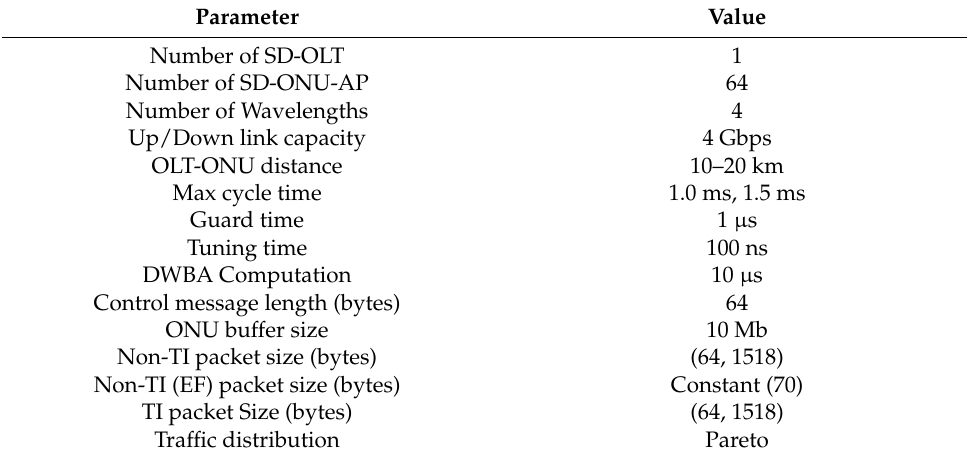
Table 4. Simulation parameters.